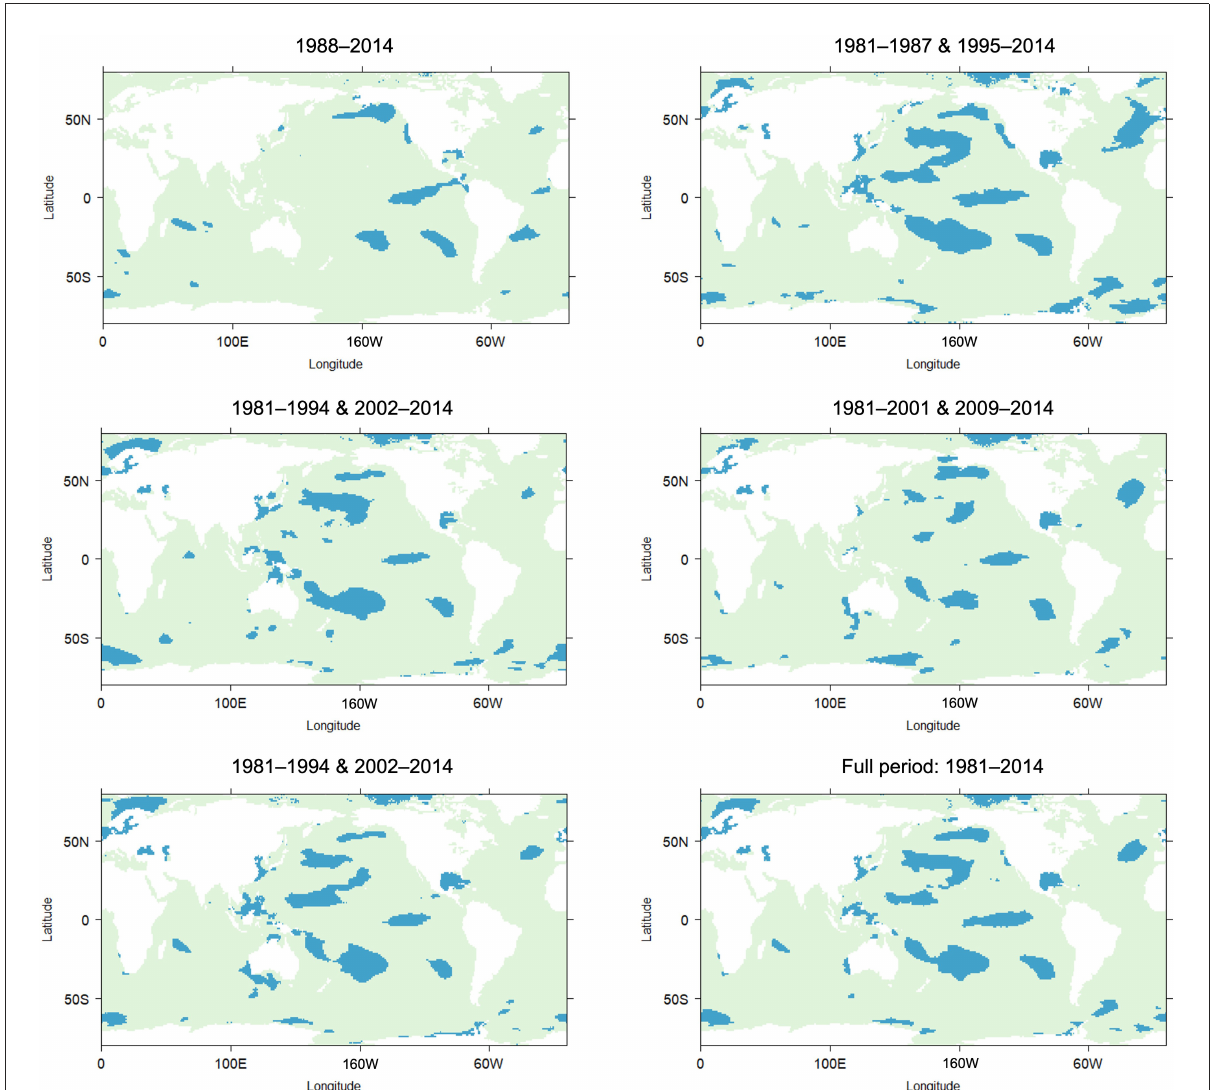
FIGURE5 Maps with clusters of significant correlations ( p < 0.05) of SSTs with May rainfall at a 1-month lead-time, indicated in blue for the five folds and over the whole available